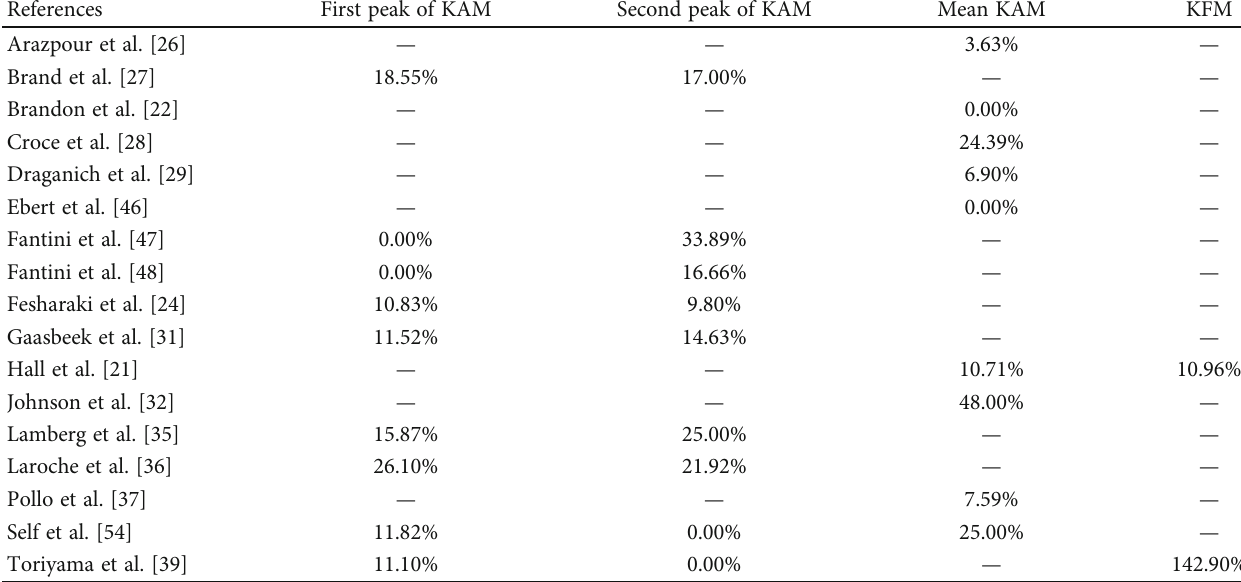
Table 4: The maximum change of KAM between braced and unbraced condition.